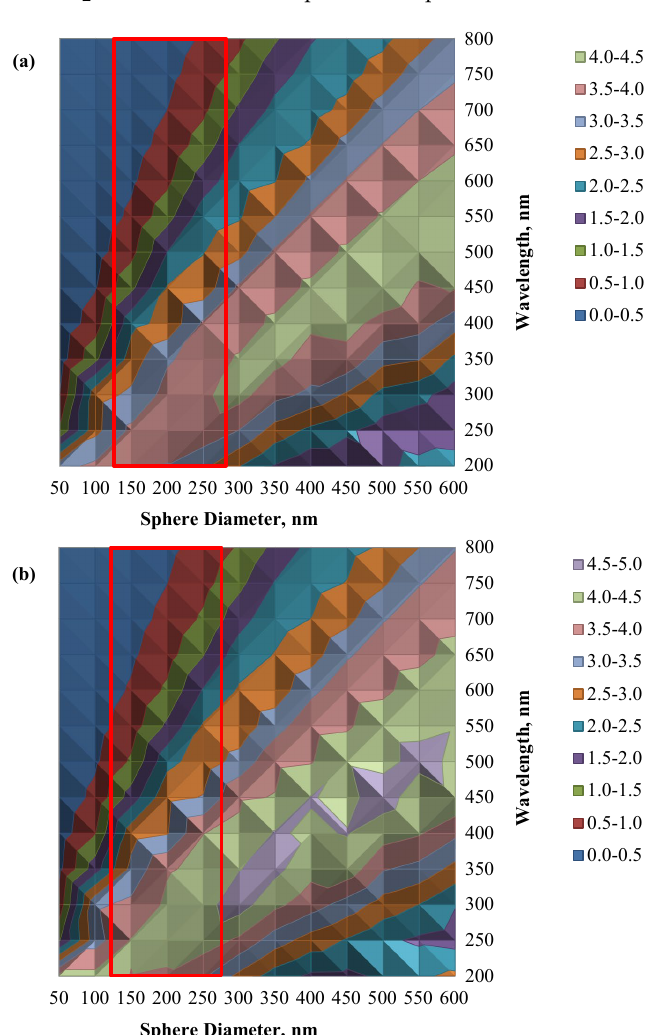
Figure 11. ( a ) The contour plot of the scattering efficiency, and ( b ) the contour plot of the extinction efficiency of the SiO 2 -TiO 2 core-shell structure with a shell thickness of 15 nm.